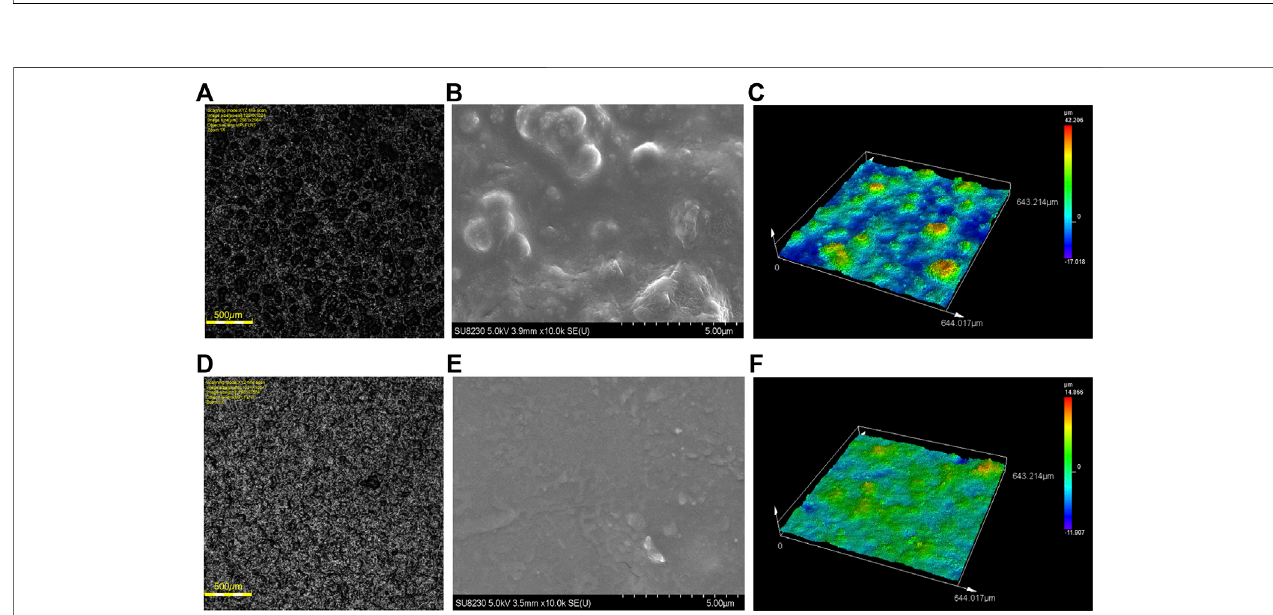
FIGURE7| MorphologyofA020andA021coatings. (A) ConfocalLasermicroscopeimageoftheA020coating. (B) SEMimageoftheuniformandcrack-freeA020 coating. (C) Confocal Laser microscope 3D image reconstruction of the A020 coating. (D) Confocal Laser microscope image of the A021 coating (E) SEM image of the uniform and crack-free A021 coating. (F) Confocal Laser microscope 3D image reconstruction of the A021 coating.